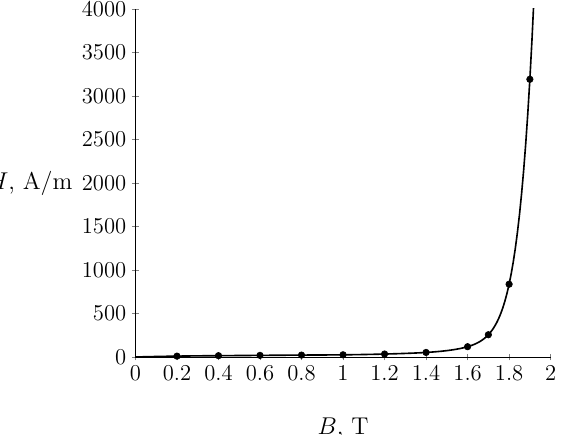
Figure 3. Manufacturer’s magnetization characteristic of the test transformer